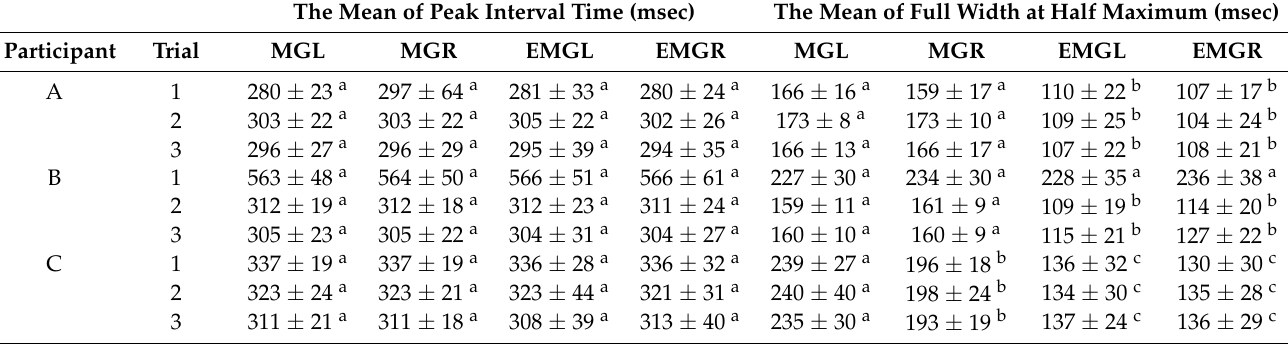
Table 2. The mean of peak interval time and the mean of full width at half maximum. Values with the same superscript letters showed no significant difference in rows ( p > 0.05). The Mean of Peak Interval Time (msec) The Mean of Full Width at Half Maximum